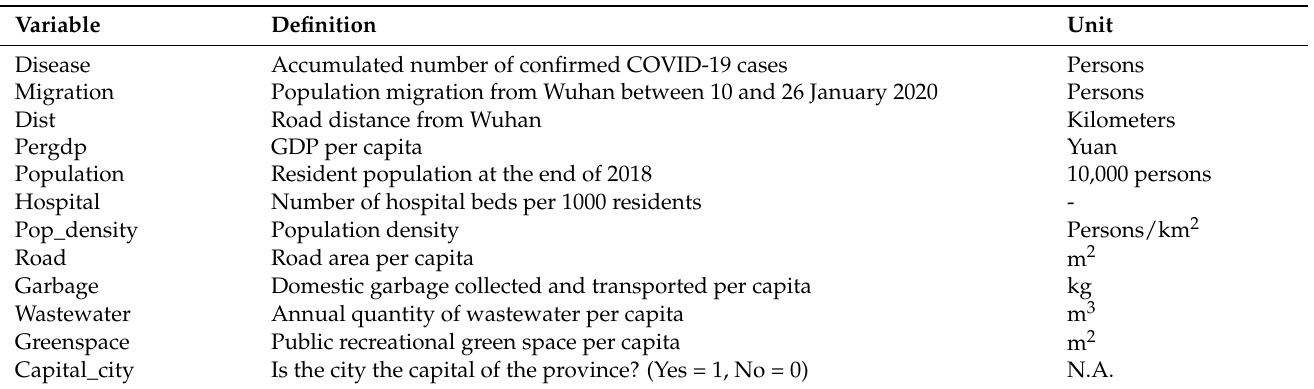
Table 1. Definitions of variables.